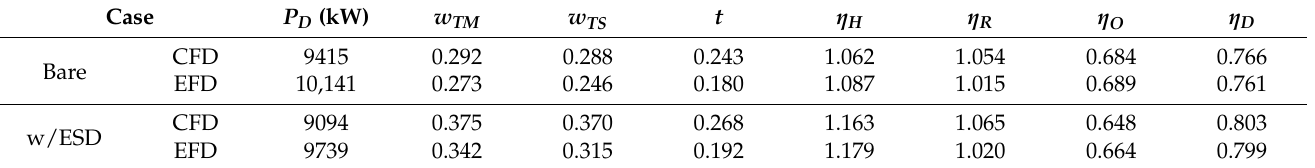
Table 10. Test conditions for the cavitation test.